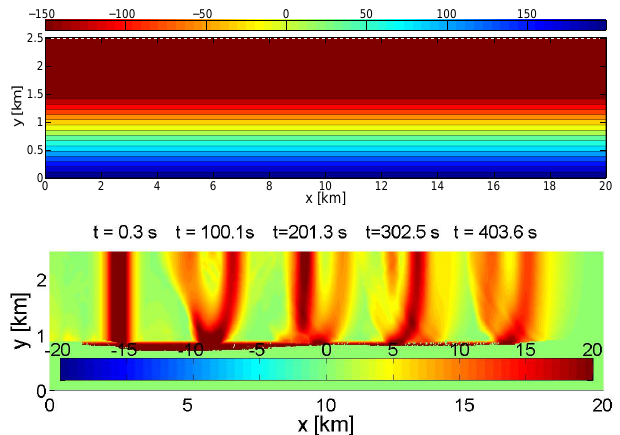
Fig. 9. Upper panel, employed bathymetry for the trapezoidal chan- nel. Due to symmetry, only one half of the channel is depicted. The color bar gives the total depth in m, negative numbers indicating points below still water level and positive values indicate land. The dashed white line indicated the location for the evaluation of the transects. Lower panel, surface elevation in m at different times for A = 27m. Here, the color bar indicates the water elevation in m.